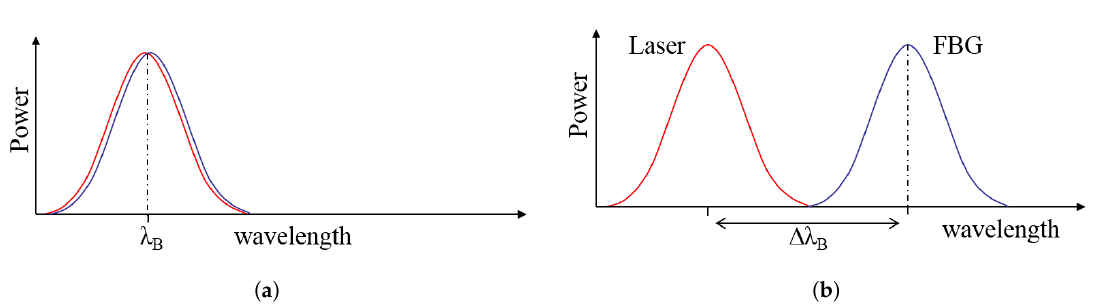
Figure 1. Principle of operation of an FBG optical switch. ( a ) The FBG and laser spectra are matched, resulting in maximum reflected intensity, and hence, the switch is in the off state; ( b ) The FBG and laser spectra are separated, resulting in minimum reflected intensity, and hence, the switch is in the on state.